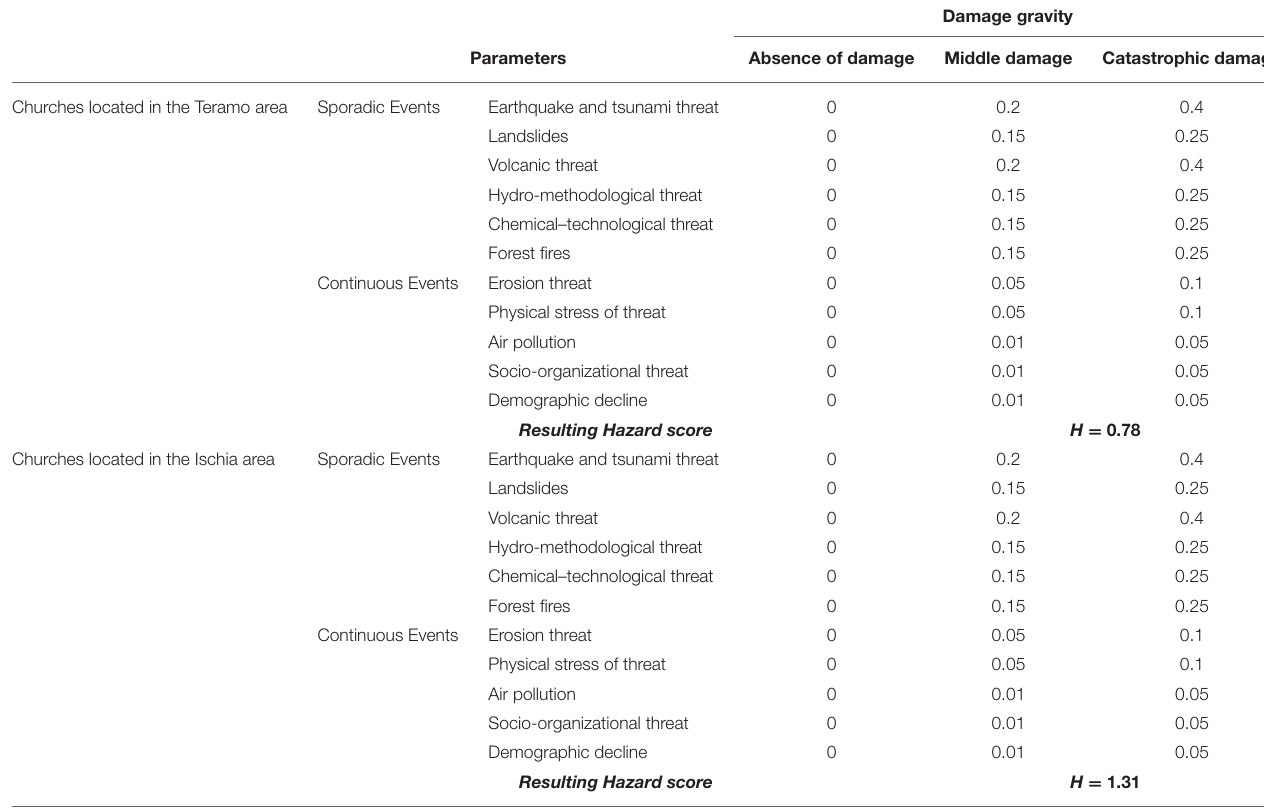
TABLE 7 | Scenarios description and classification of threats for church samples.